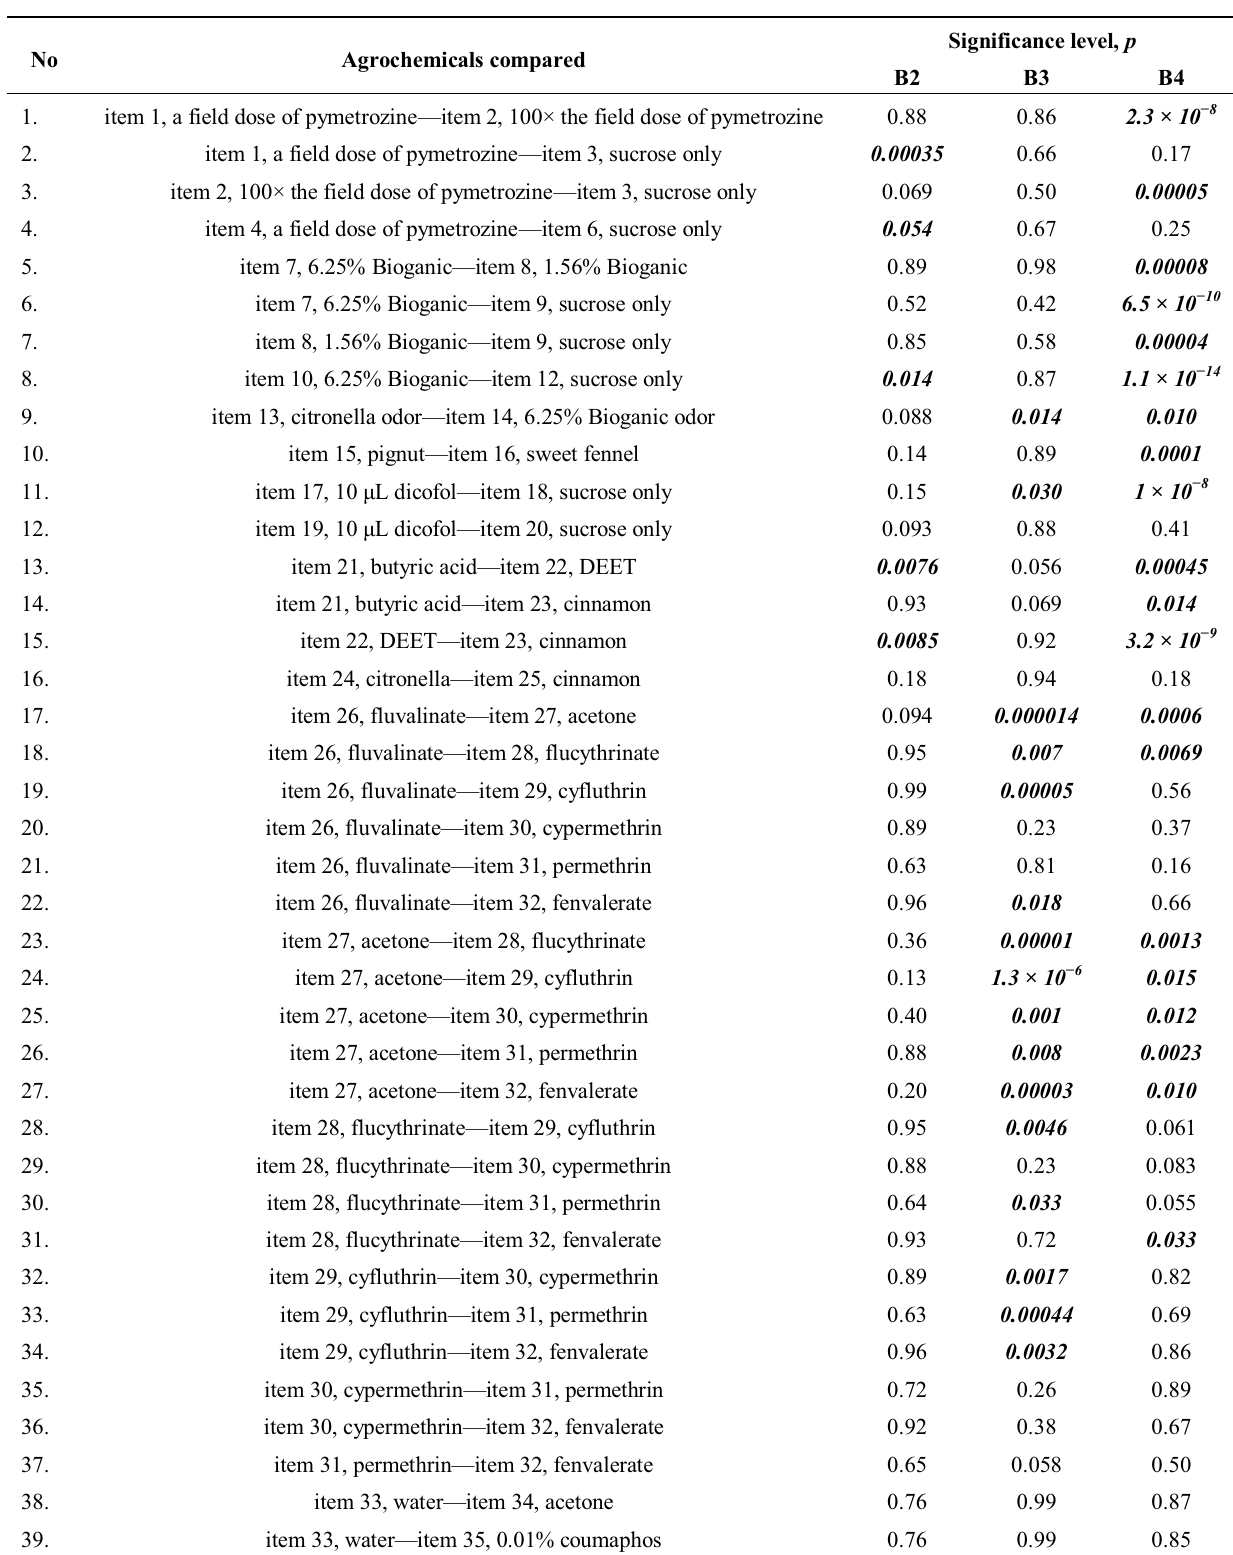
Table 3. Learning curve comparison. The significance level of each comparison is found below. Item numbers correspond to Tables 1 and 2. Values in bold italics are considered significant, p <